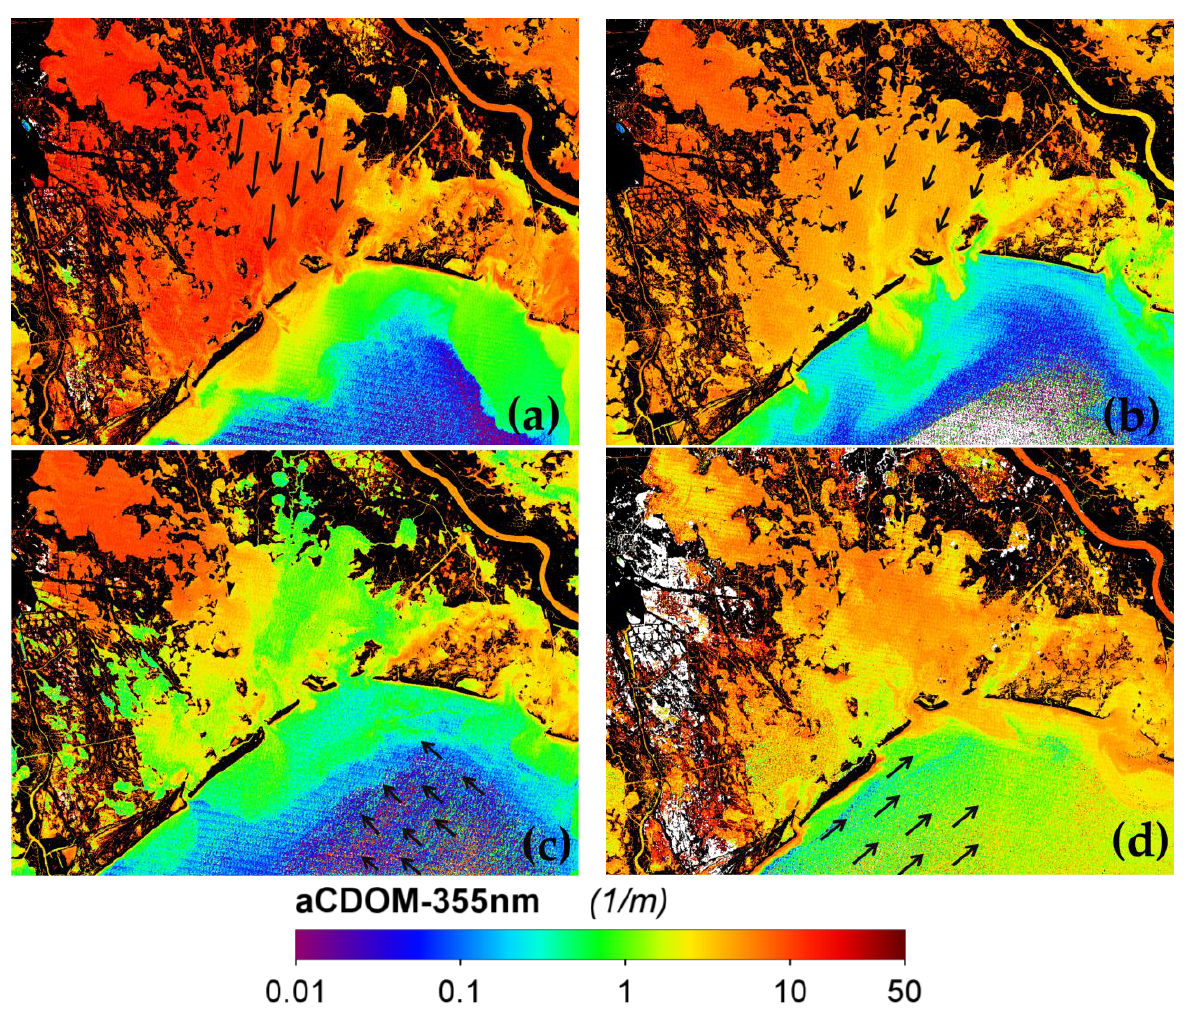
Figure 9. Landsat-5 TM-derived CDOM imagery of the Barataria Bay and Louisiana coastal waters obtained using Equation 4 during ( a ) a strong frontal system (25 February 2010), ( b ) a weak high-pressure system (8 November 2010), ( c ) elevated freshwater release at DPFD (12 February 2011) and ( d ) high MR flow condition (1 April 2011) (black arrows represent approximate daily mean wind direction, with longer arrows indicating stronger winds and vice versa